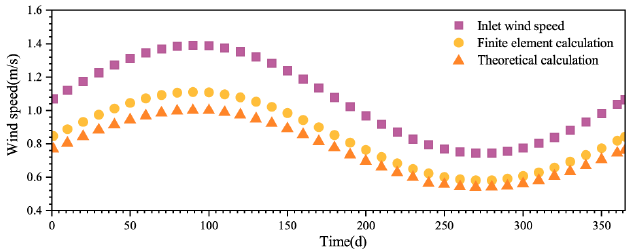
Figure 9. Comparative analysis of the theoretical calculation results and numerical calculation results.